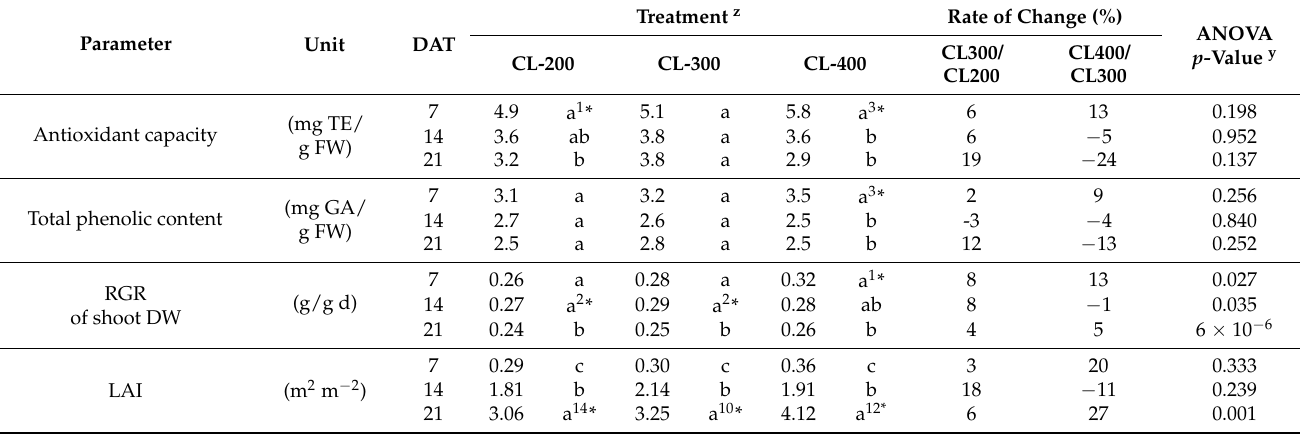
z For the treatment, CL-200, CL-300, and CL-400 represent the light period of 24 h per day with the light intensity of 200, 300, and 400 µ mol m − 2 s − 1 , respectively. For each treatment and for each parameter, numbers followed vertically (column-wise comparison) by different alphabet letters are statistically not different from each other ( 1 * indicates the probability of ANOVA (the multiple comparison by Tukey) is 1 * p < 0.05, 2 * p < 0.01, 10* p < 1.0 × 10 − 11 , 12 * p < 1.0 × 10 − 13 , and 14 * p < 1.0 × 10 − 15 ), and the order of magnitude corresponds to the order of alphabet, i.e., a > b > c. y The p -values for the ANOVA of the multiple mean comparison among the three CL treatments by Tukey’s method applied to each row (row-wise comparison). The probabilities that are less than p = 0.05 are shown in bold